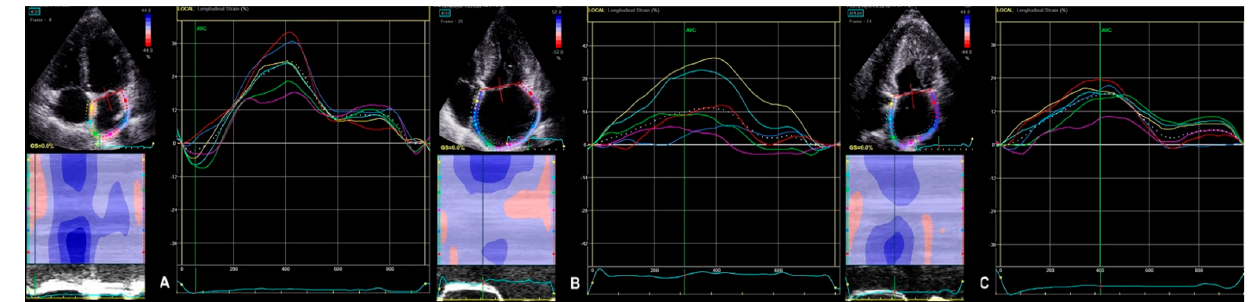
Figure 2. The example of 2D LA strain analysis derived from a four-chamber apical view of a healthy person ( A ); HCM patient without FA diagnosis ( B ); HCM patient with FA diagnosis ( C ).